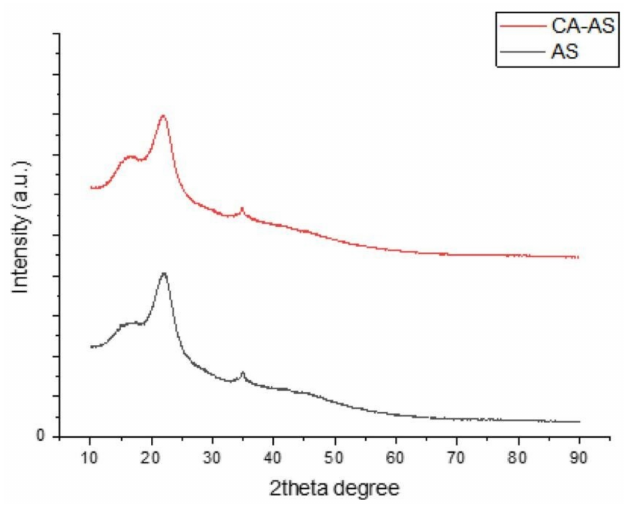
Figure 16. XRD pattern of AS and CA-AS